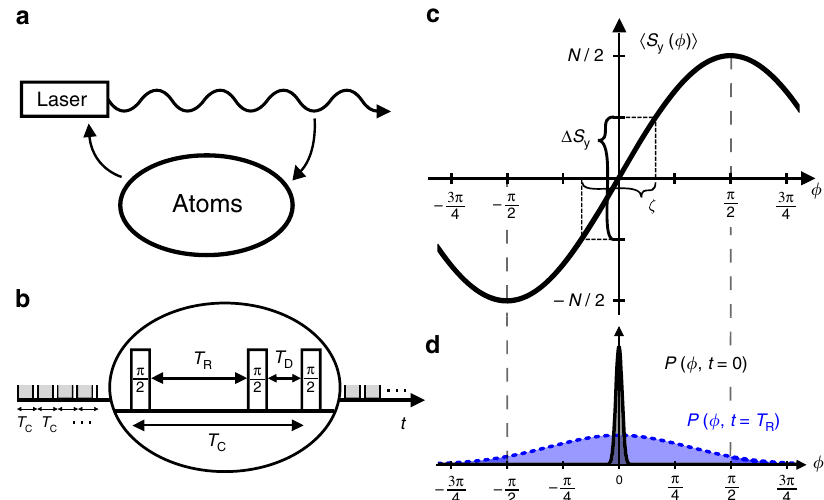
Fig. 1 Setup and noise processes. a Measurement and feedback loop to stabilize the laser frequency to an atomic transition. b Periodic measurements with Ramsey time T R and dead time T D in each cycle of total time T C lead to increased instability from the Dick effect. c Quantum projection noise Δ S y for N particles limits the clock stability for short interrogation times but can be decreased with squeezed states thus reducing the inferred phase uncertainty ffiffiffiffi p ζ ¼ ξ = N where ξ is the Wineland spin squeezing parameter. d For longer T R the distribution P ( ϕ , t ) of phases broadens substantially due the laser ’ s ; π (cid:3) interval gives the coherence time decoherence. Inef fi cient feedback for phases outside the ½(cid:2) π 2 2